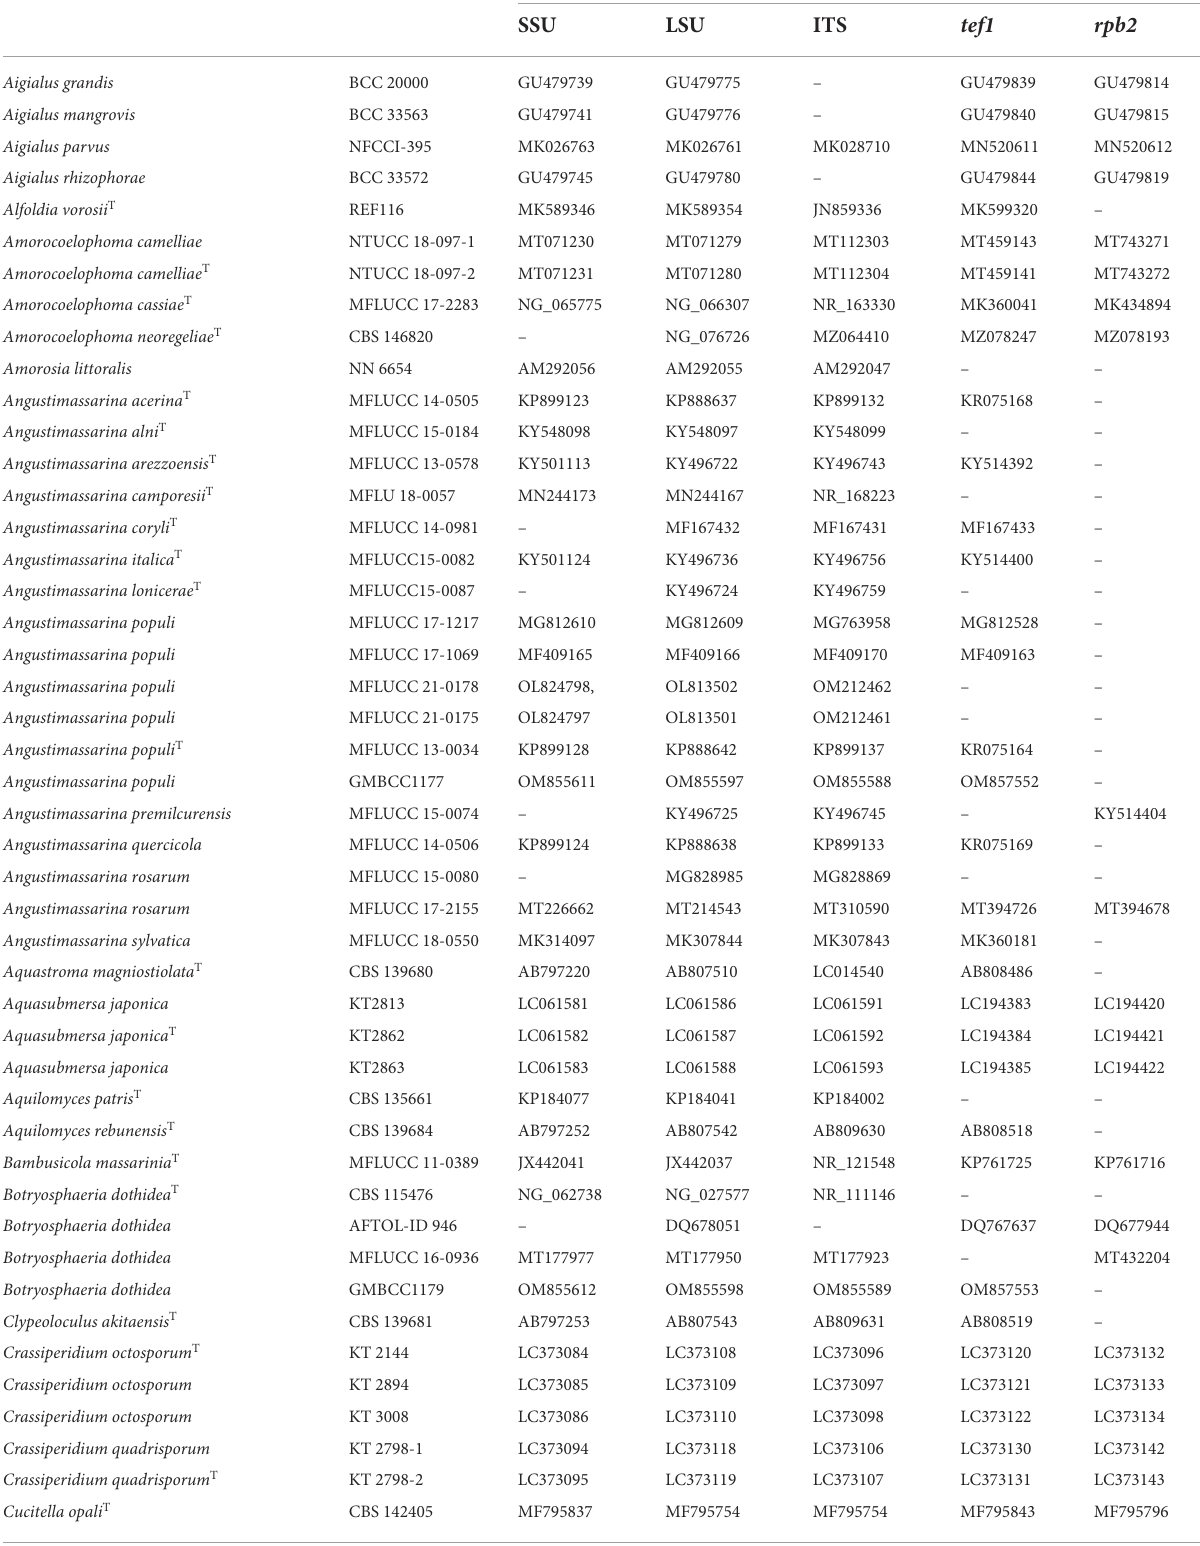
TABLE 2 Taxa used in the phylogenetic analyses and their corresponding GenBank numbers. Species Strain